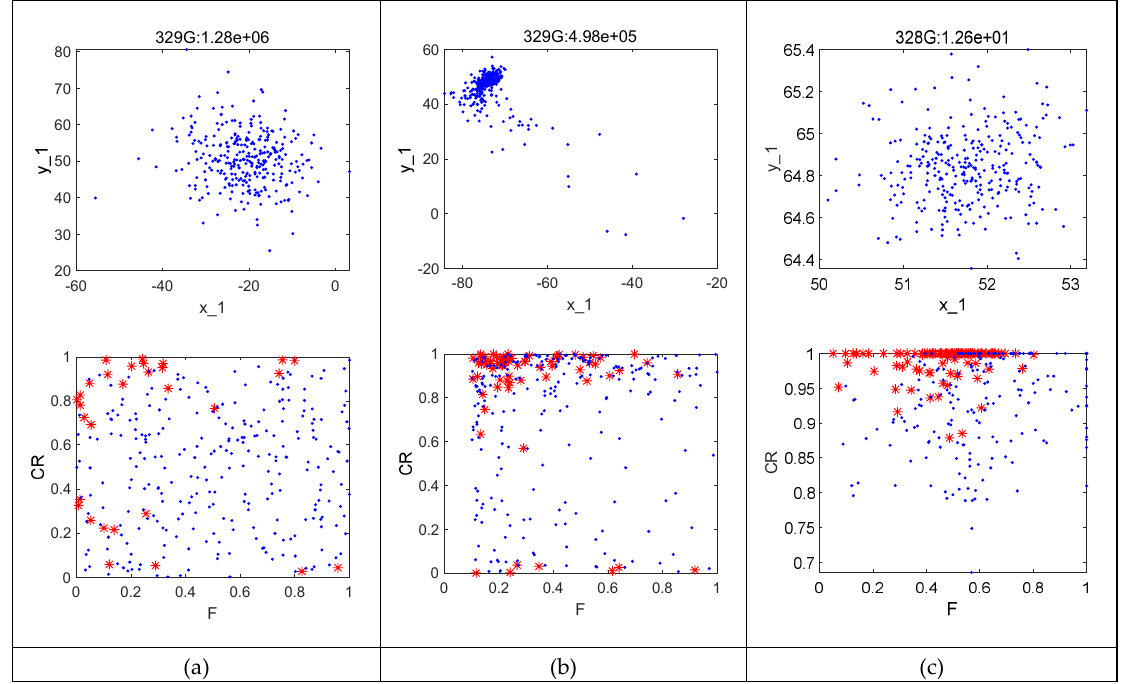
Figure 1. Individual and parameters distribution maps of three parameter strategies for f1: ( a ) random strategy; ( b ) jDE strategy; and ( c ) SHADE strategy.